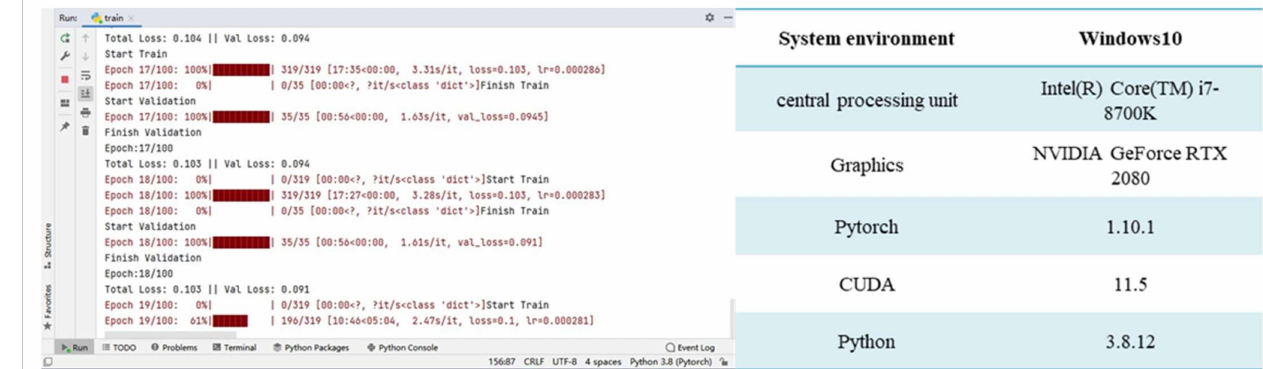
Figure 11. Deep-learning model training and experimental environment configuration diagram.